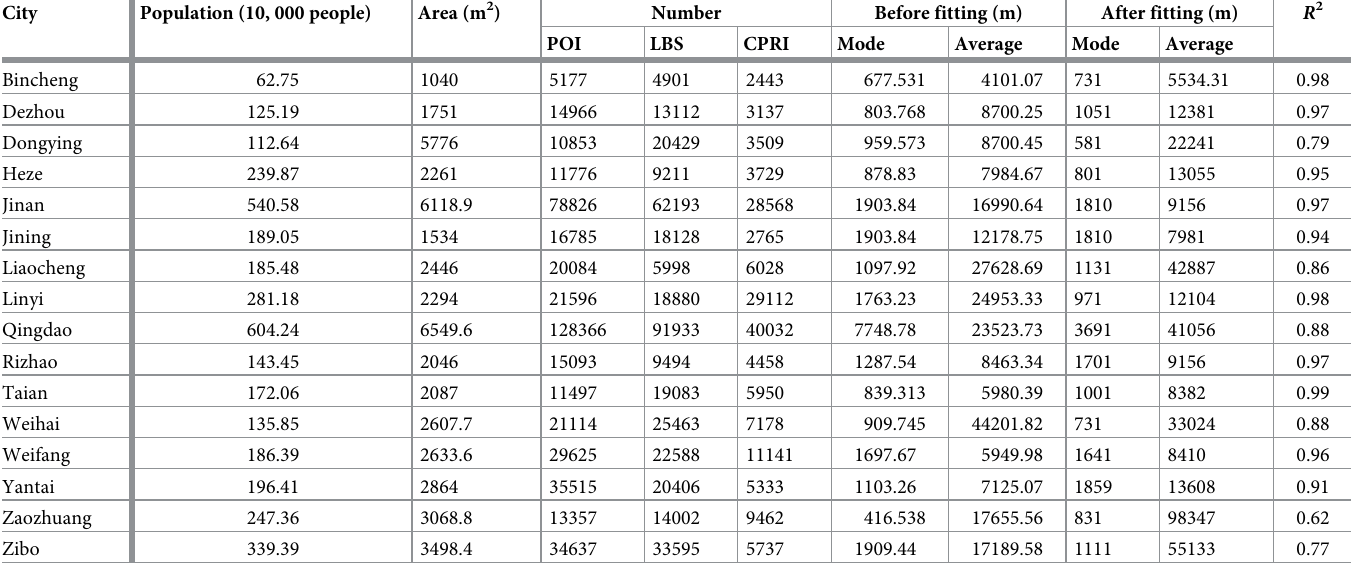
Table 1. Statistics results of 16 prefecture-level